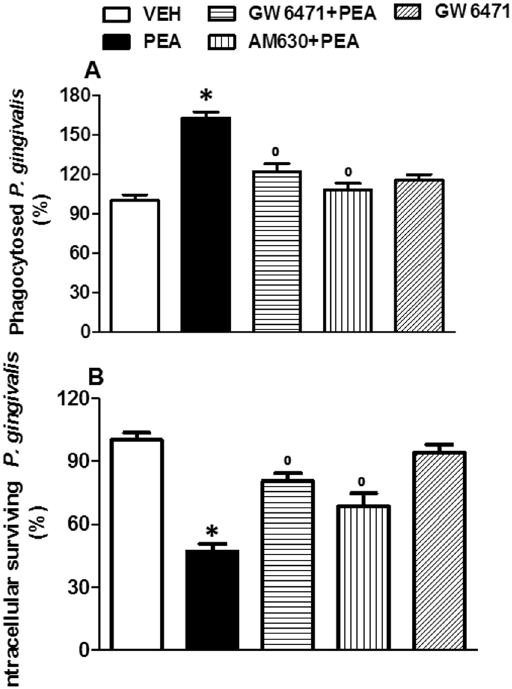
GW6471 (10 µ M) + PEA, or AM630 (100 nM) + PEA, or GW6471 alone. The number of bacteria ingested